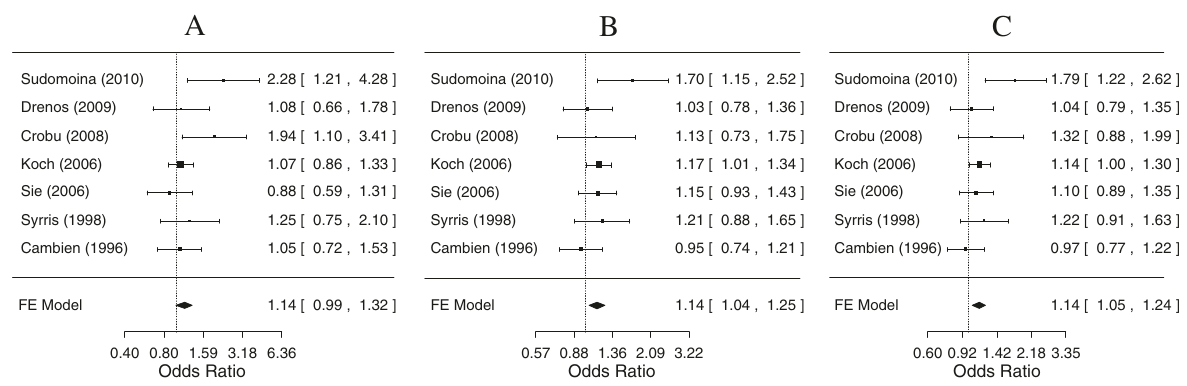
Figure 1 Meta-analysis for coronary heart disease risk depending on the rs1800469 ( − 509 C/T) polymorphism in the TGFB1 gene. ORs and corresponding 95% confidence intervals (CIs) are shown. Fixed effects were reported because no significant heterogeneity between studies was observed. A . Comparison of the homozygous TT genotype with the wild type CC genotype ( p =0.08); B . Comparison of the heterozygous CT genotype with the wild type CC genotype ( p =0.004); C . Comparison of the TT+CT genotype with the wild type CC genotype ( p =0.003).